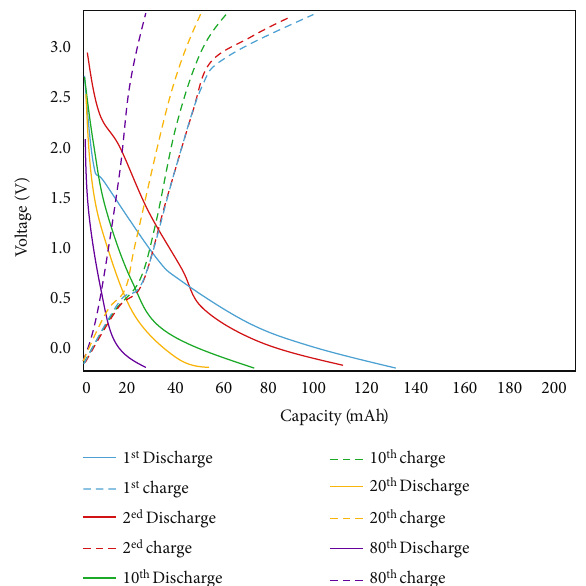
Figure 7: Voltage-speci fi c capacity performance graphs of monomeric CsPbBr3 and CsPbBr3@CNT composites under di ff erent